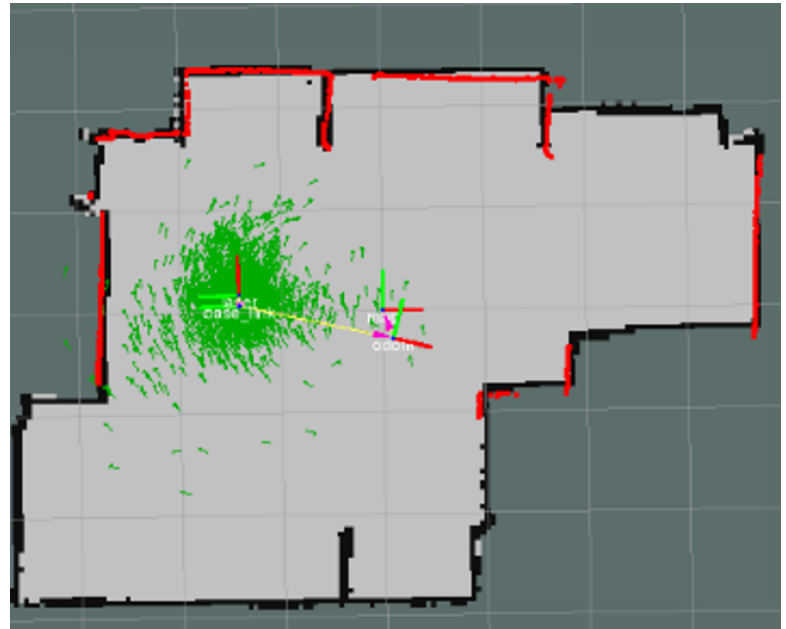
Fig. 5. amcl package